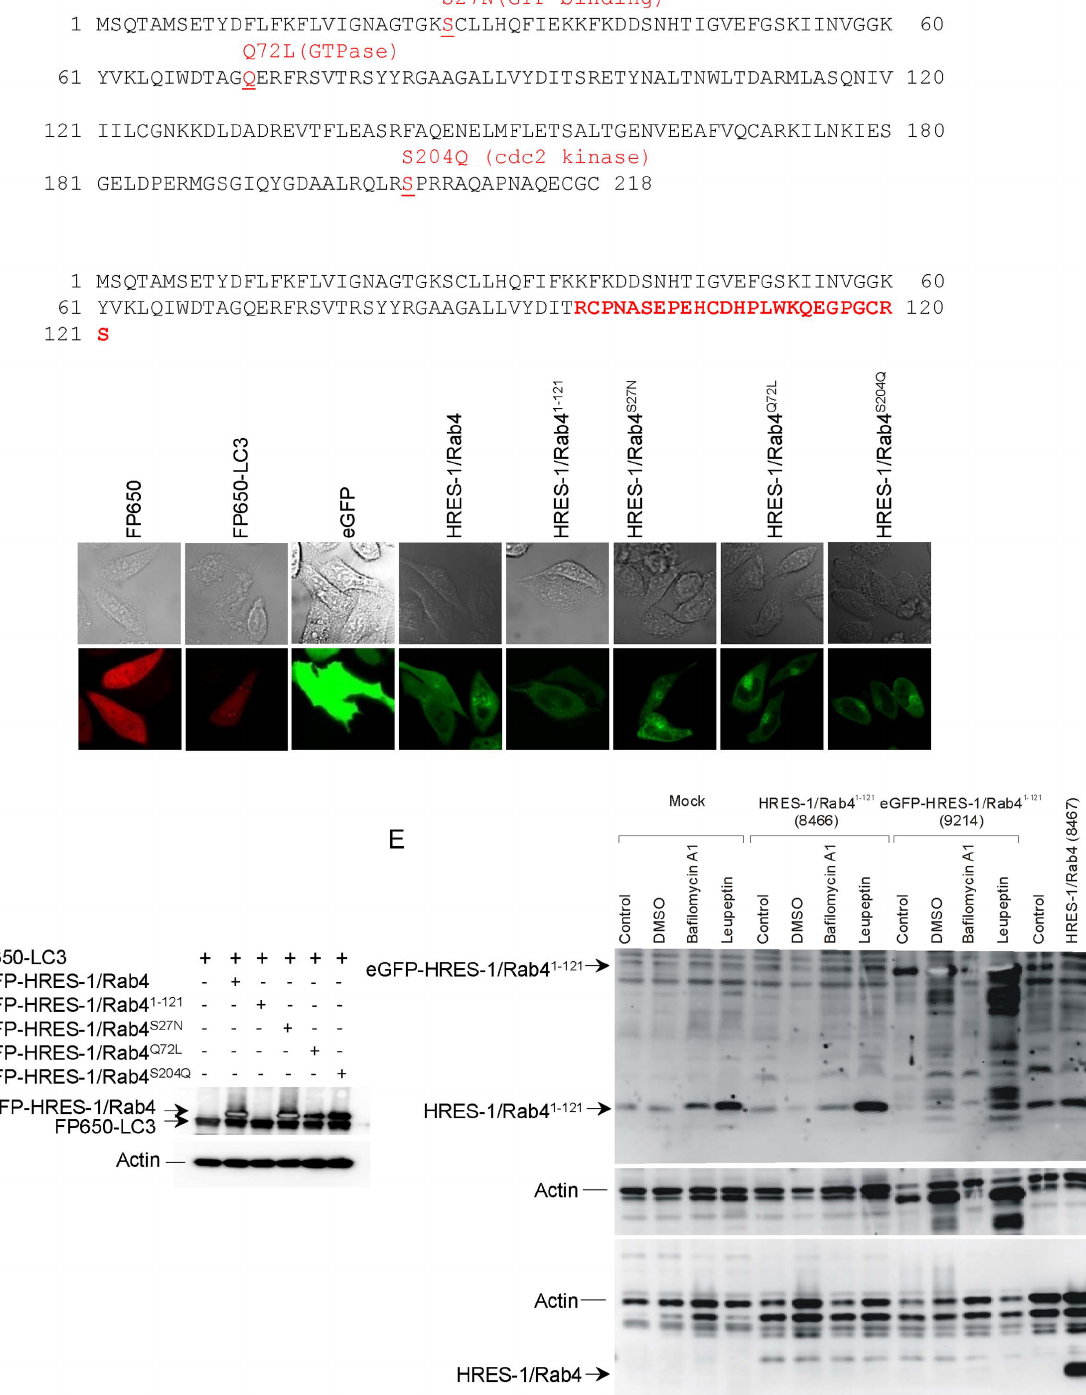
PLOS ONE | www.plosone.org